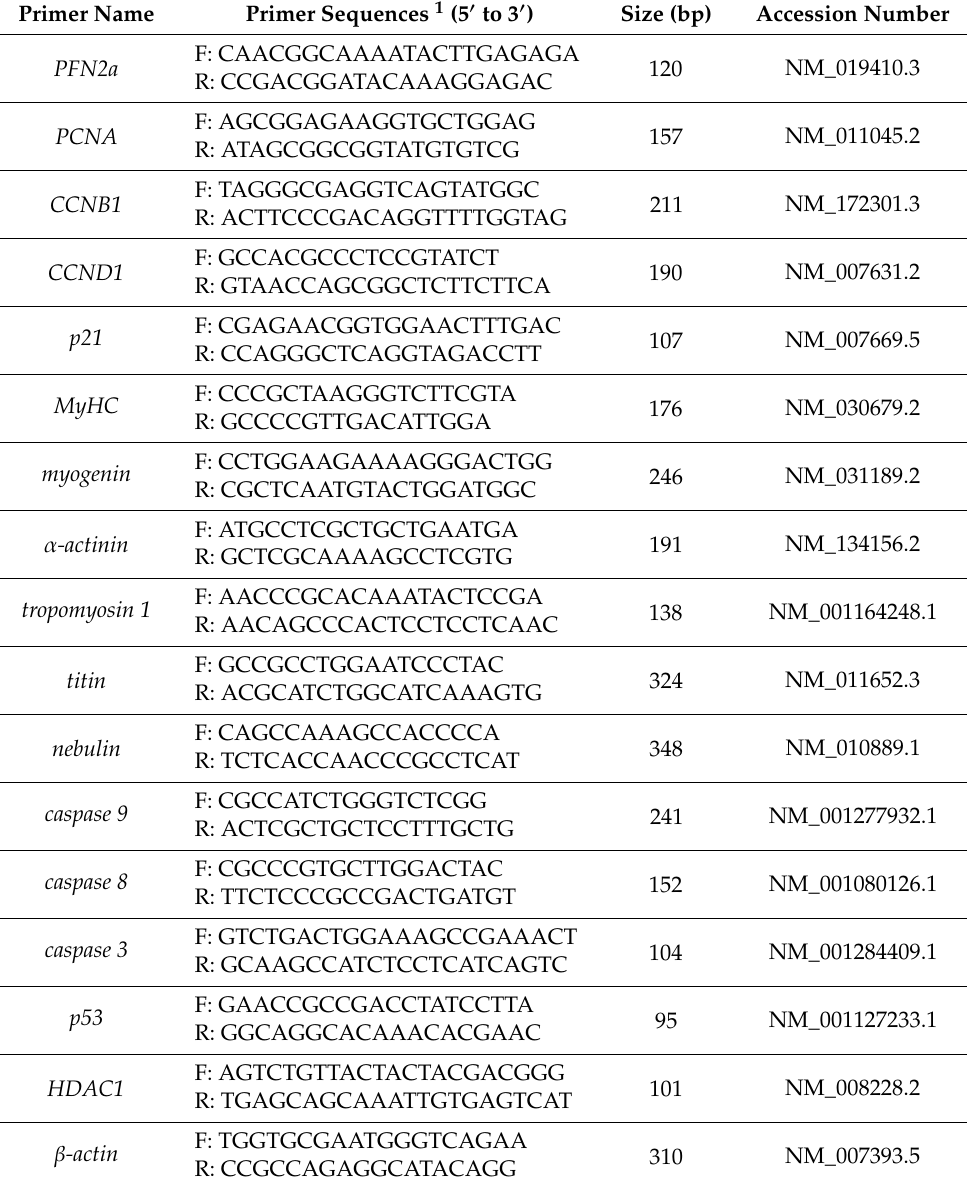
Table 3. Primers used for